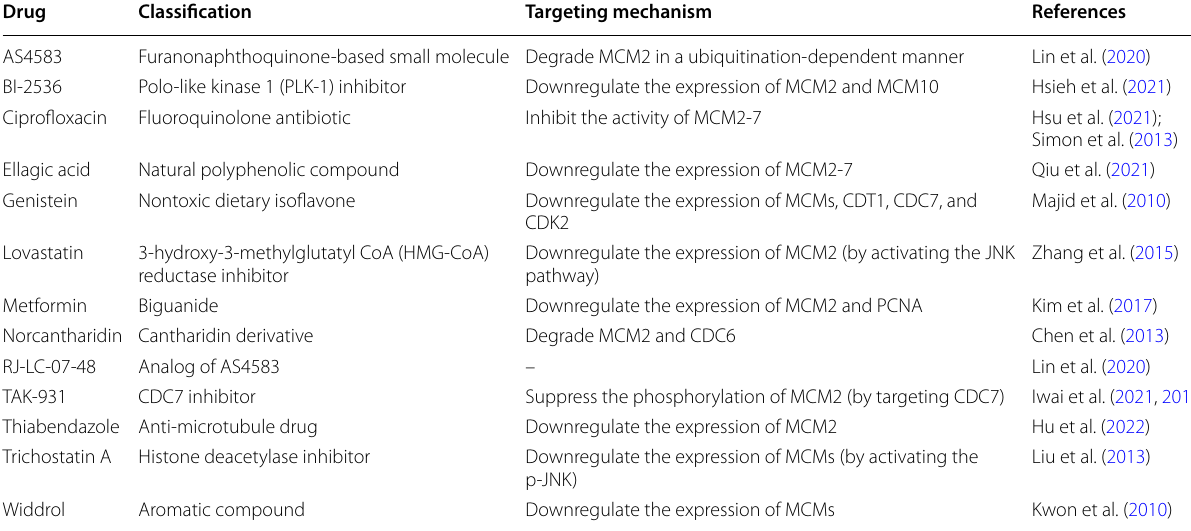
Table 2 The available MCM2 inhibitors